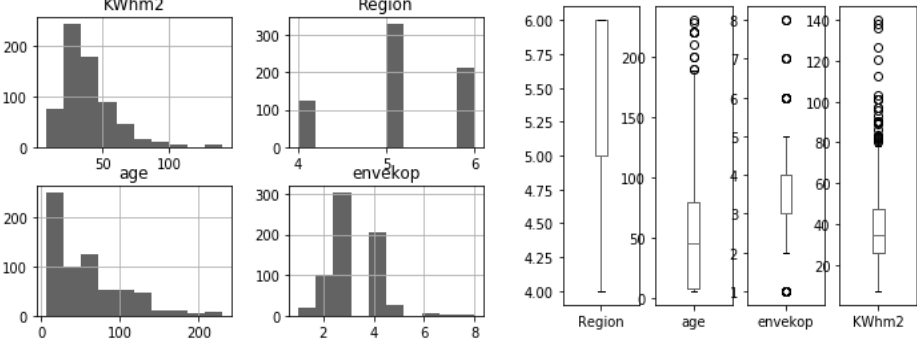
Figure 10. Histogram representation of some parameters in the third